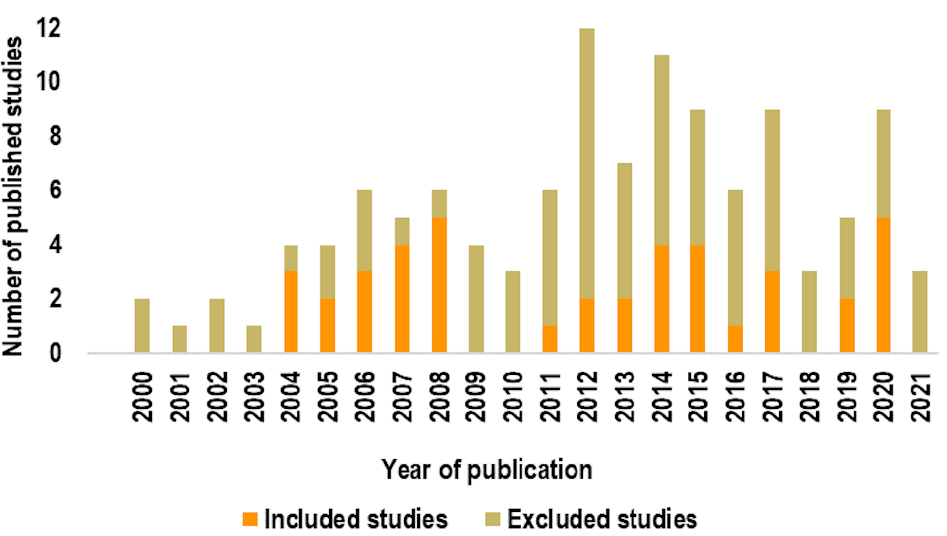
Figure 3. Temporal trend of publication of studies.